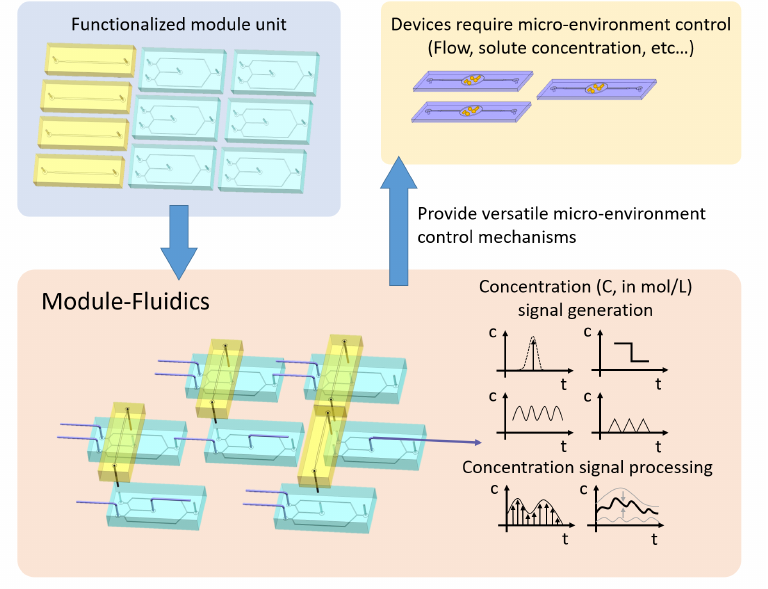
Figure 1. The Module-Fluidic generates the desired concentration profile that enables downstream microfluidic devices’